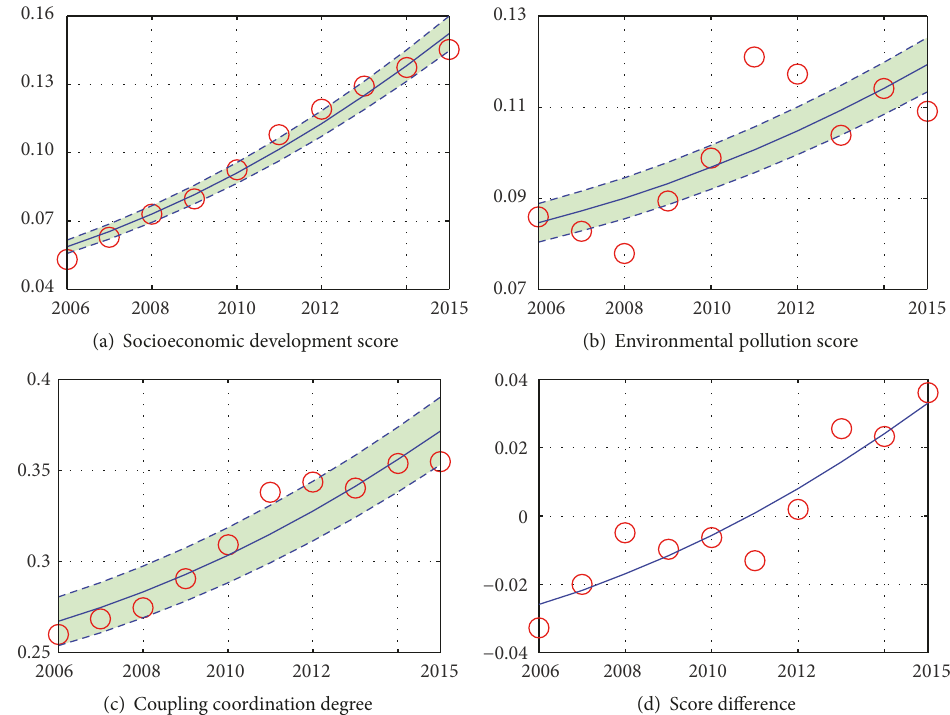
Figure 2: Fitting results to socioeconomic development score, environmental pollution score, coupling coordination degree, and score difference of the BTH